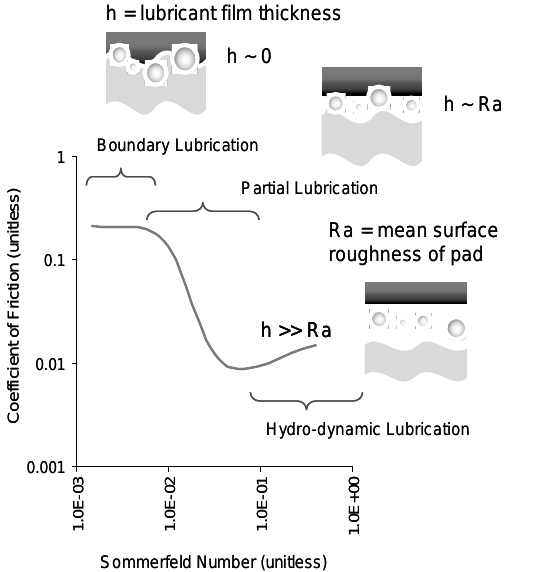
Fig.4 Stribeck – Gumbel curve for CMP Applications (Courtesy of Prof. Philipossian, The University of Arizona).